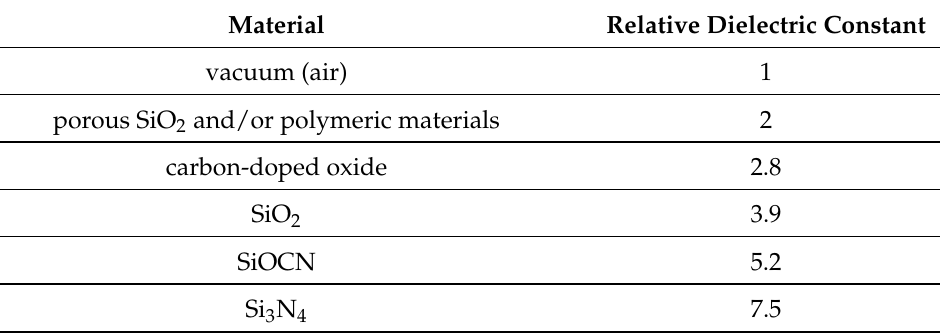
Table 2. Low-K materials considered in this